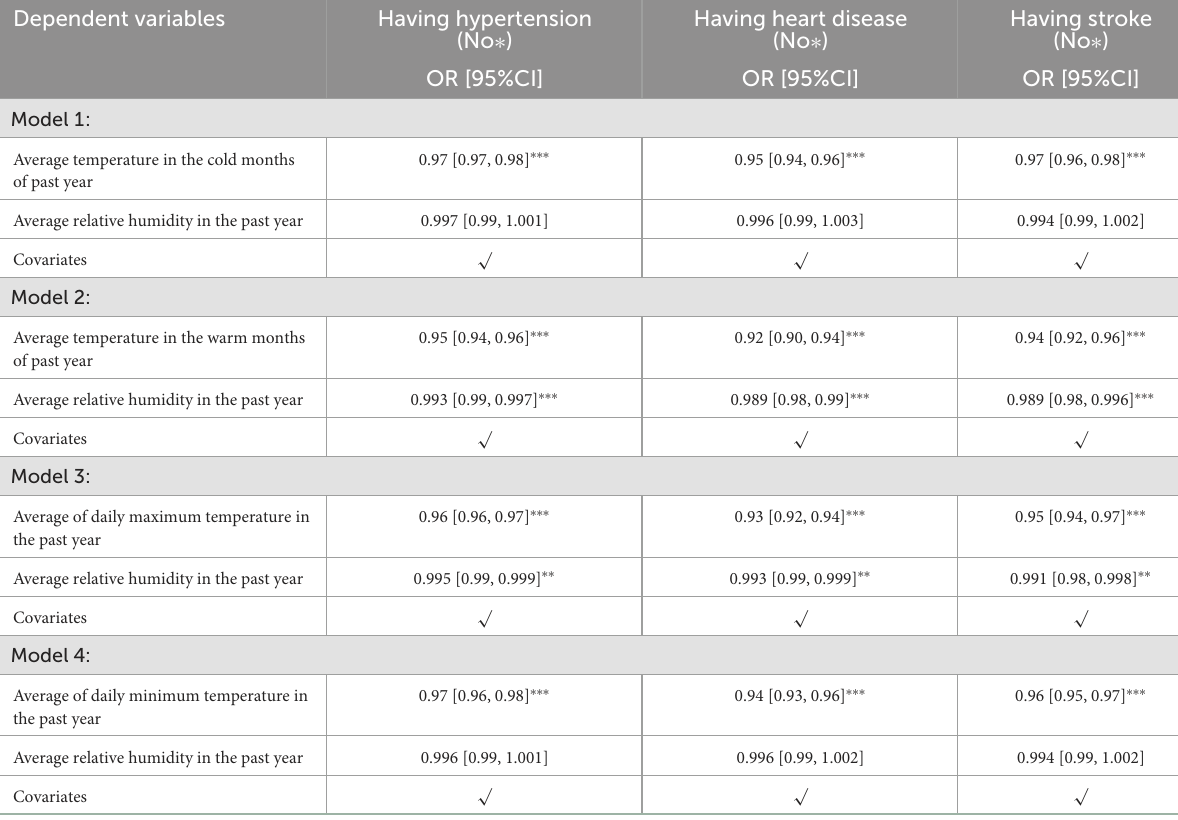
TABLE 4 Effects of temperature and relative humidity on CVD during 2002–2018: Odds ratios (OR) from hierarchical GEE models. Dependent variables